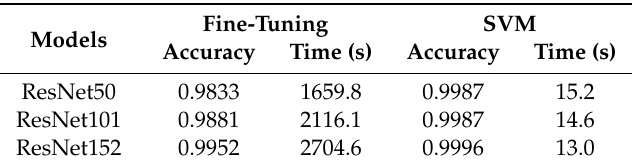
Table 5. Classification Accuracies.